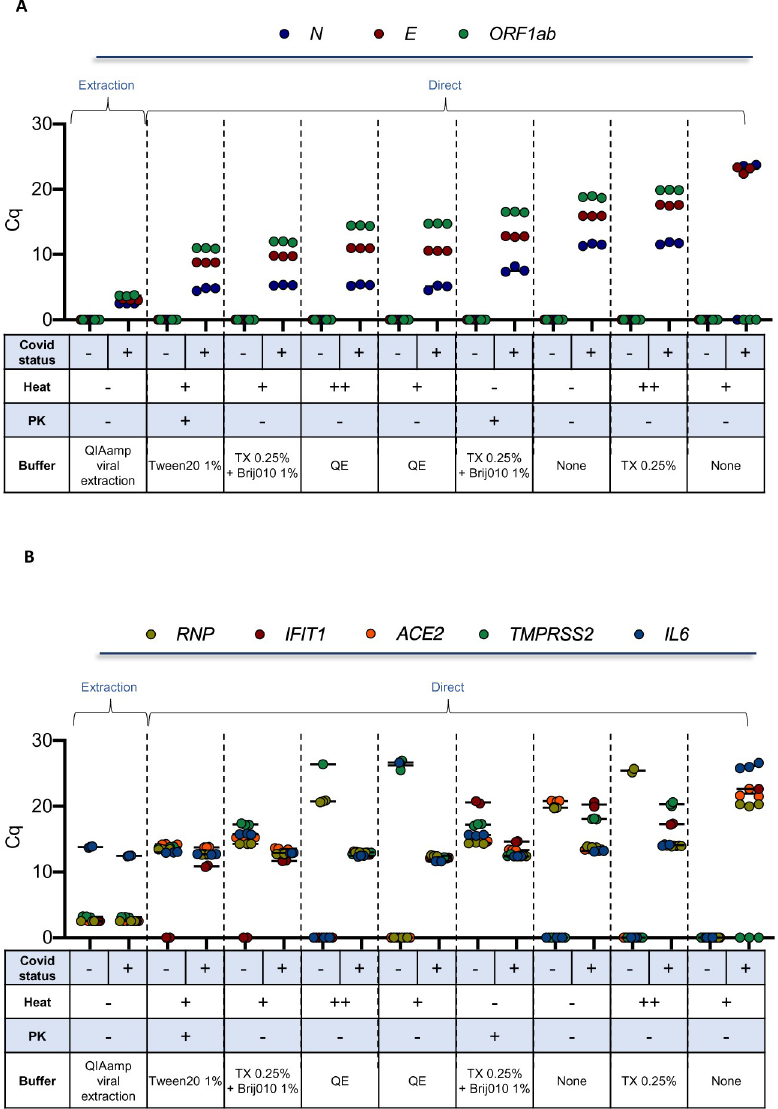
Fig 5. Detection of viral and cellular genes using inactivating lysis buffers-based protocols. Two clinical samples of known COVID-19 status (one positive and one negative) sampled in a commercial VTM medium, were aliquoted and then treated in parallel using the indicated detergent conditions (selected from S5 Fig) in the presence or absence of PK. RNA was extracted as a control. Biomark-HD RT-qPCR was performed using (A) viral (N, E, ORF1ab) and (B) cellular (ACE2, IFIT1, IL6, TMPRSS and RNP) primers/probe sets. Legend: +: 10 min at 65˚C; ++: 10 min at 65˚and 5 min at 95˚C; TX: Triton X-100; QE: Quick Extract TM DNA Extraction Solution. The Cq presented are representative of two independent experiments performed in